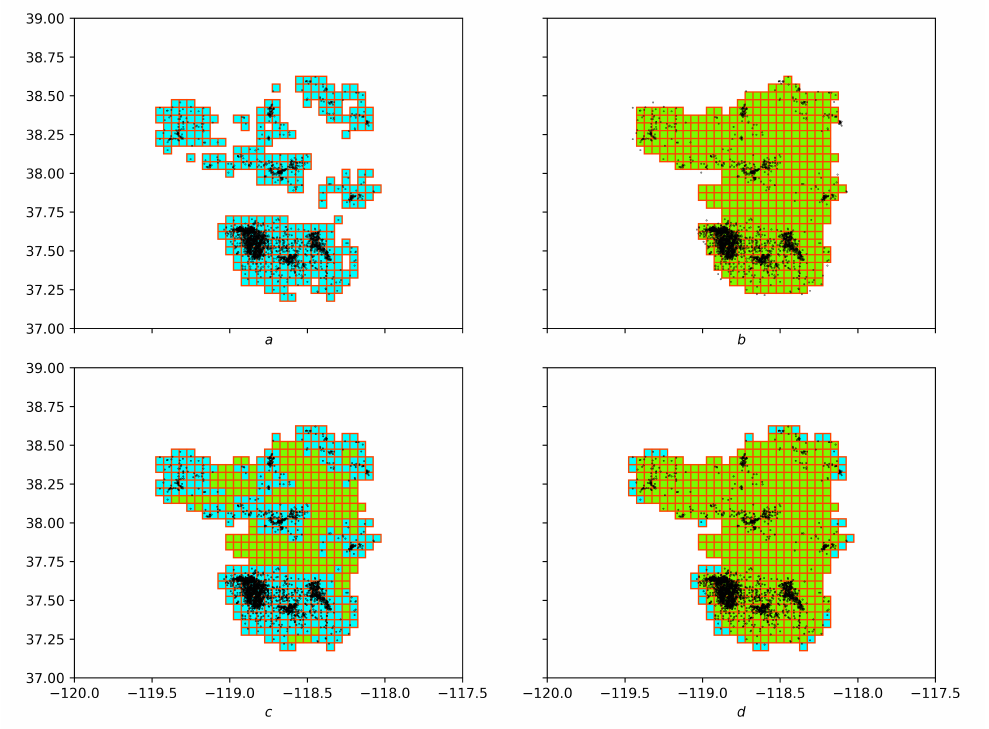
Figure 9. ( a ) Ext shell for the set A . ( b ) Shell of Int for the set A . ( c ) Shell H ( A ) = Ext ( A ) ∪ ( Int ( A ) \ Ext ( A )) (Int against the background of Ext). ( d ) Shell H ( A ) = Int ( A ) ∪ ( Ext ( A ) \ Int ( A )) (Ext against the background of